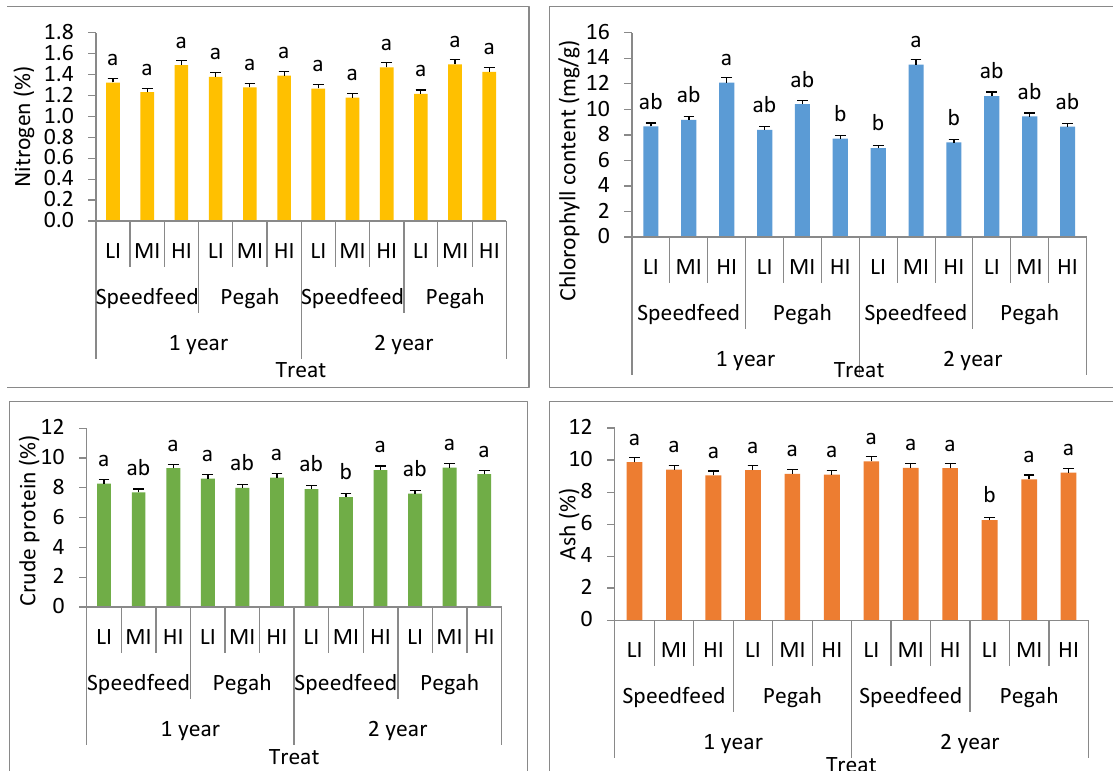
Fig. 2: Variations in chemical properties of the two varieties of sorghum under different irrigation levels in different years. Different lower-cases for interaction on the bars show significant differences (Duncan, P < 0.05). (HI): High irrigation, (MI): Medium irrigation and (LI): Low irrigation